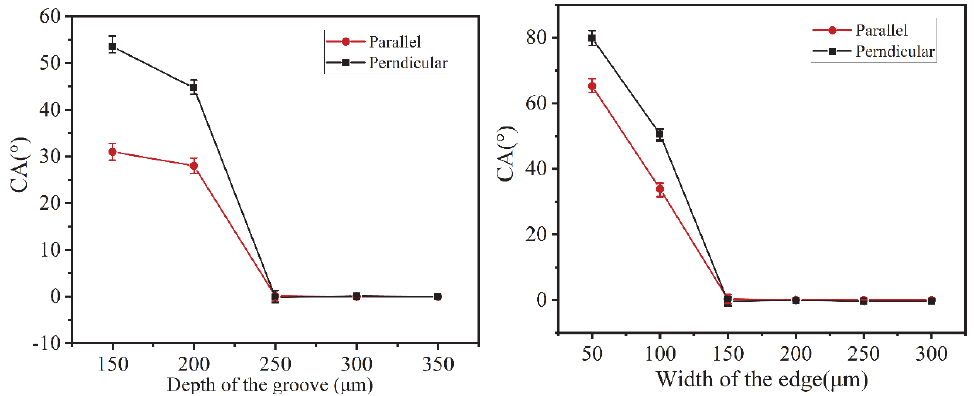
Figure 5. Effect of macrostructure on contact angle. ( a ) Effect of groove depth on contact angle. ( b ) Effect of edge width on contact angle.